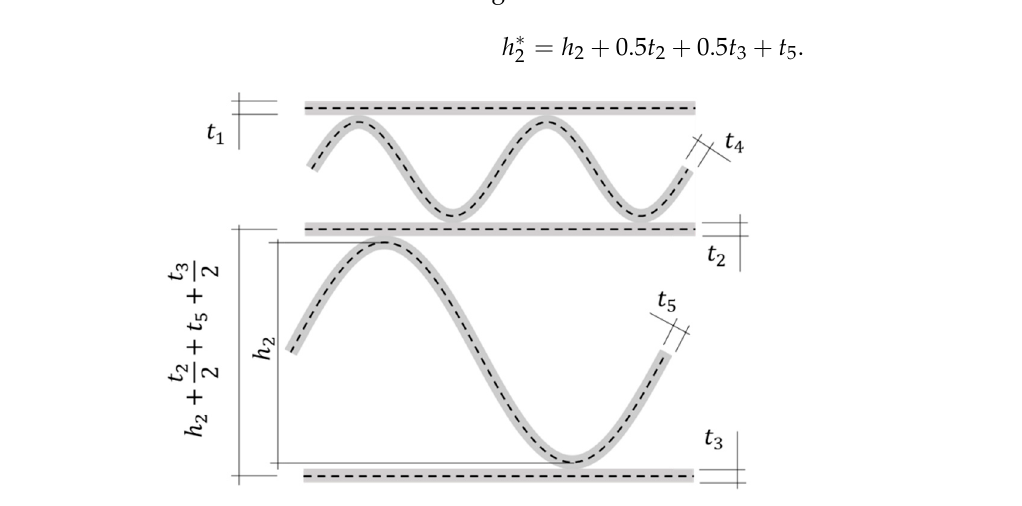
Figure 4. Thickness of all corrugated board layers and axial distance between liners in the compu- tational model.